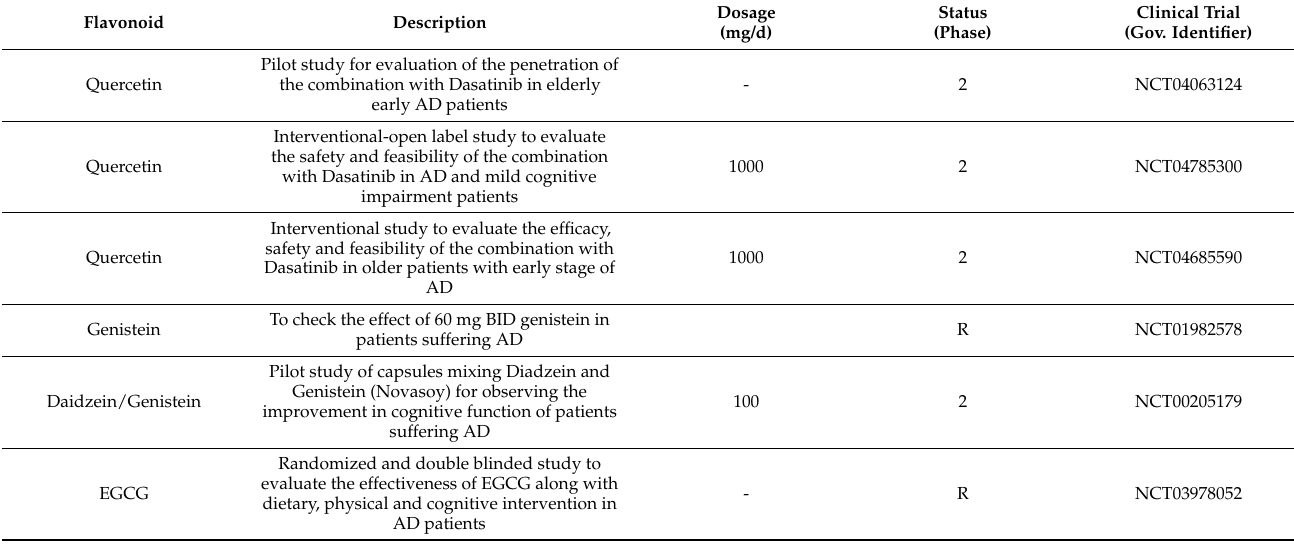
Figure 3. Structure of flavonoids on clinical trials. Table 1. Flavonoids under clinical trials [49].